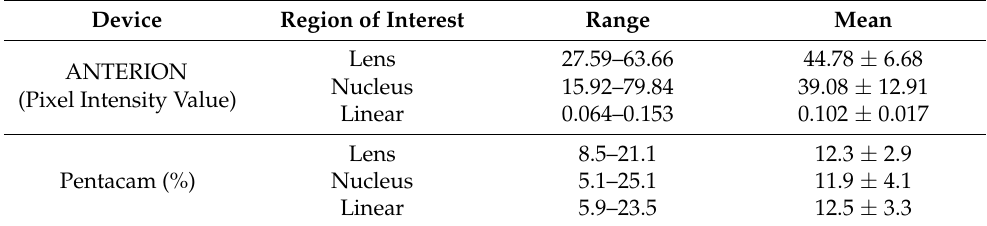
Table 1. Overview of the data provided by the different densitometric analysis methods applied to the ANTERION and Pentacam Wave AXL scans.